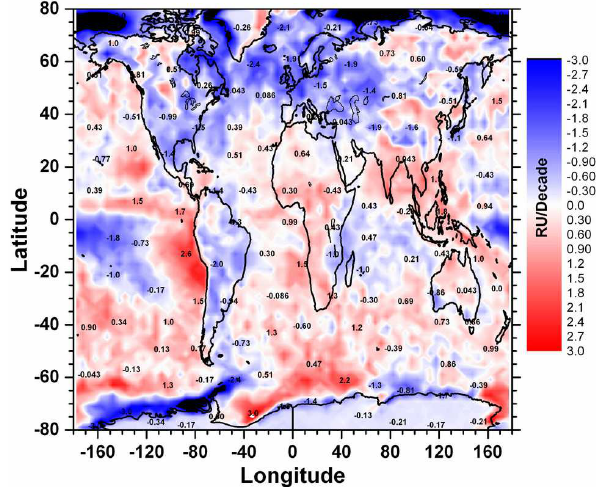
Fig. 12. Percent change in 340nm surface solar insolation as a func- tion of latitude normalized to sum to 100.